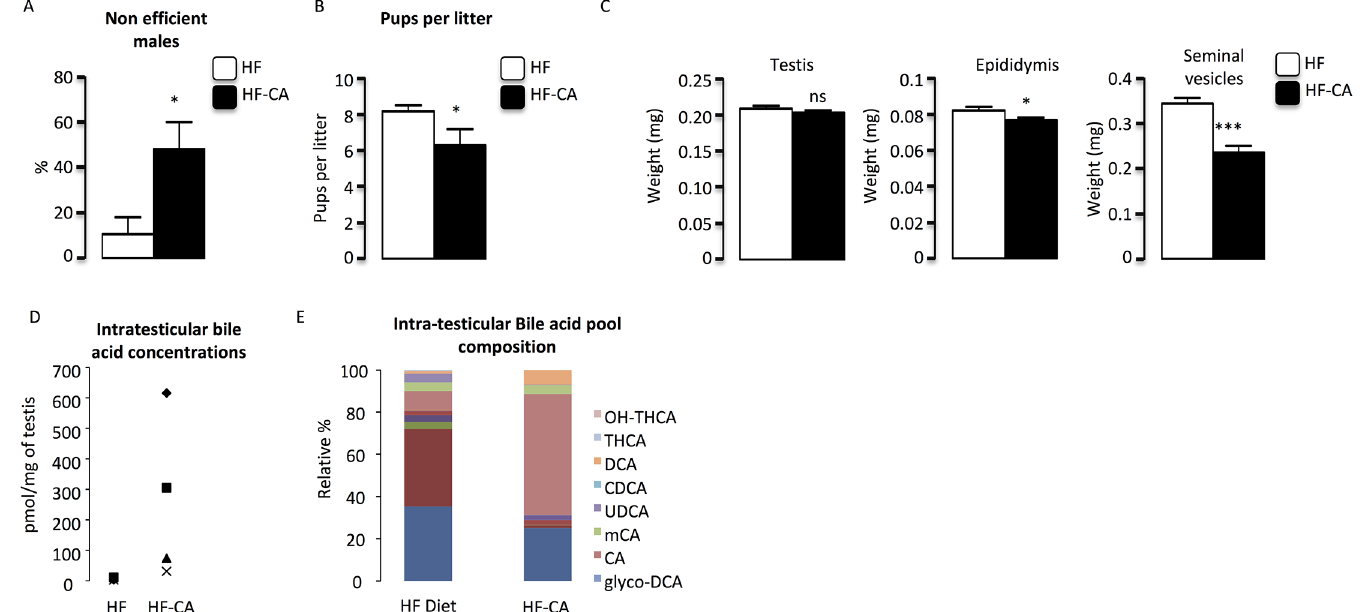
Fig 2. CA-supplementation alters male reproduction function in mice fed HF-CA diets versus HF-diet. (A) Percent of non-efficient males after 15 days of breeding with 2 C57BL/6J females in mice under HFD or HF-CA diet 4 months after the switch to HF-CA diet. (B) Number of pups per litter obtained in mice under HFD or HF-CA diet 4 months after the switch to HF-CA diet. (C) Relative testis, epididymis and seminal weights normalized to body weight in C57Bl/6 mice fed HF-diet and HF-CA diet 4 months after the switch to HF-CA diet. (n = 18 – 25 per group). ( D) Intra-testicular bile acid levels and pool composition in mice under HFD or HF-CA diet 4 months after the switch to HF-CA diet. Data represent mean ± SEM; Statistical analyses: * p < 0,05; ** p < 0,01 and *** p <